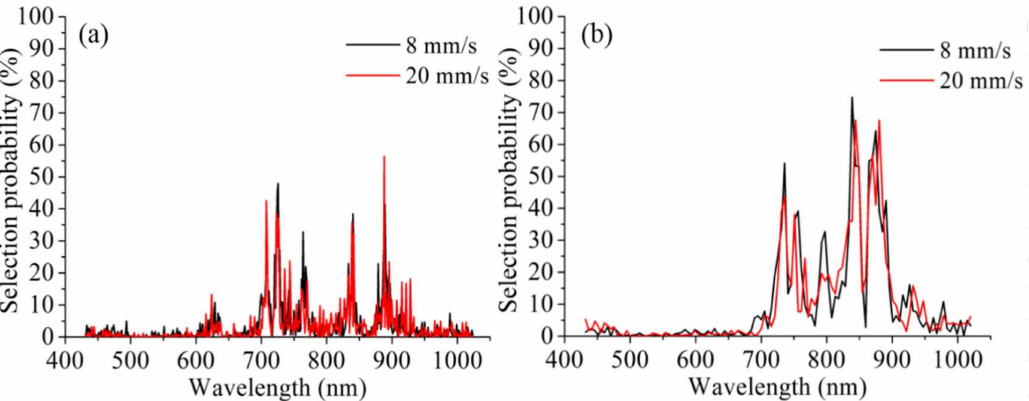
Figure 4. The selection probability of each wavelength calculated by random frog at scanning speed of 8 mm/s and 20 mm/s using 2 × 2 ( a ) and 2 × 8 ( b ) binning operation, respectively.